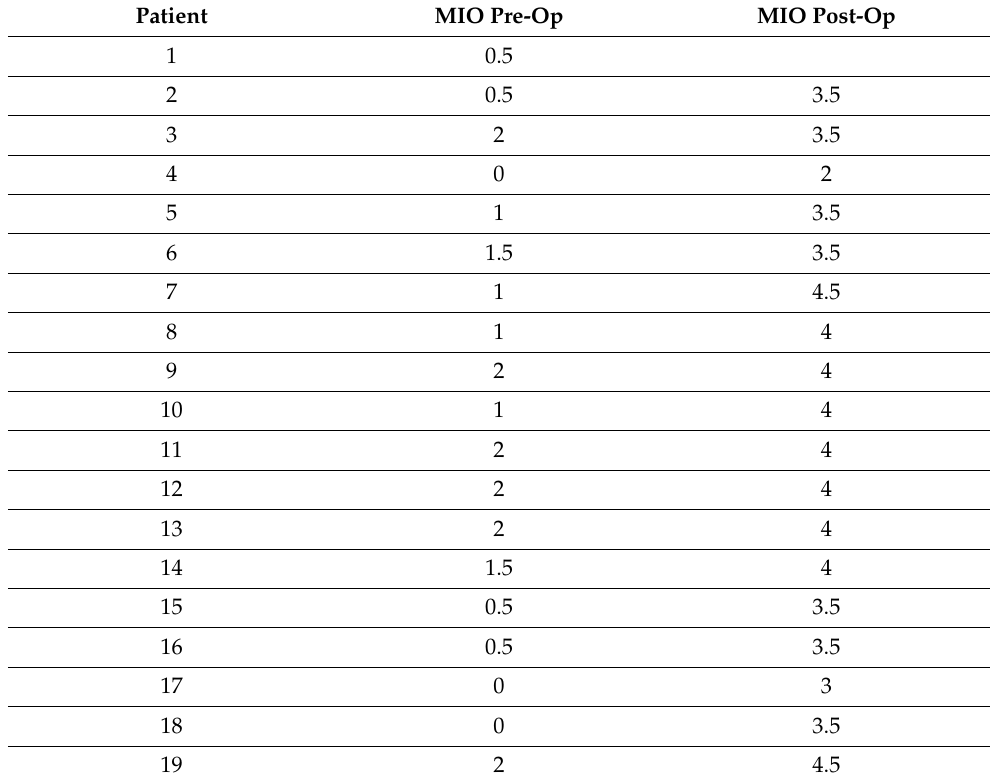
Table 3. Comparison of pre- and postoperational MIO